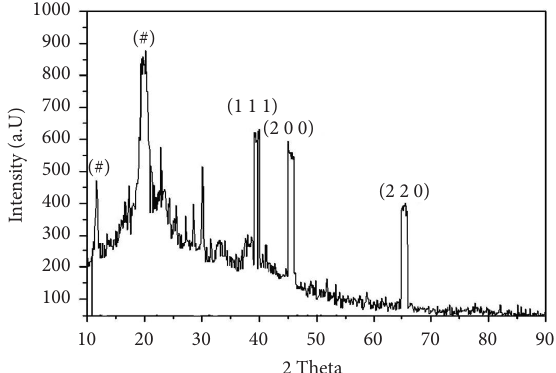
Figure 5: XRD spectrum of green synthesized silver nanoparticles.